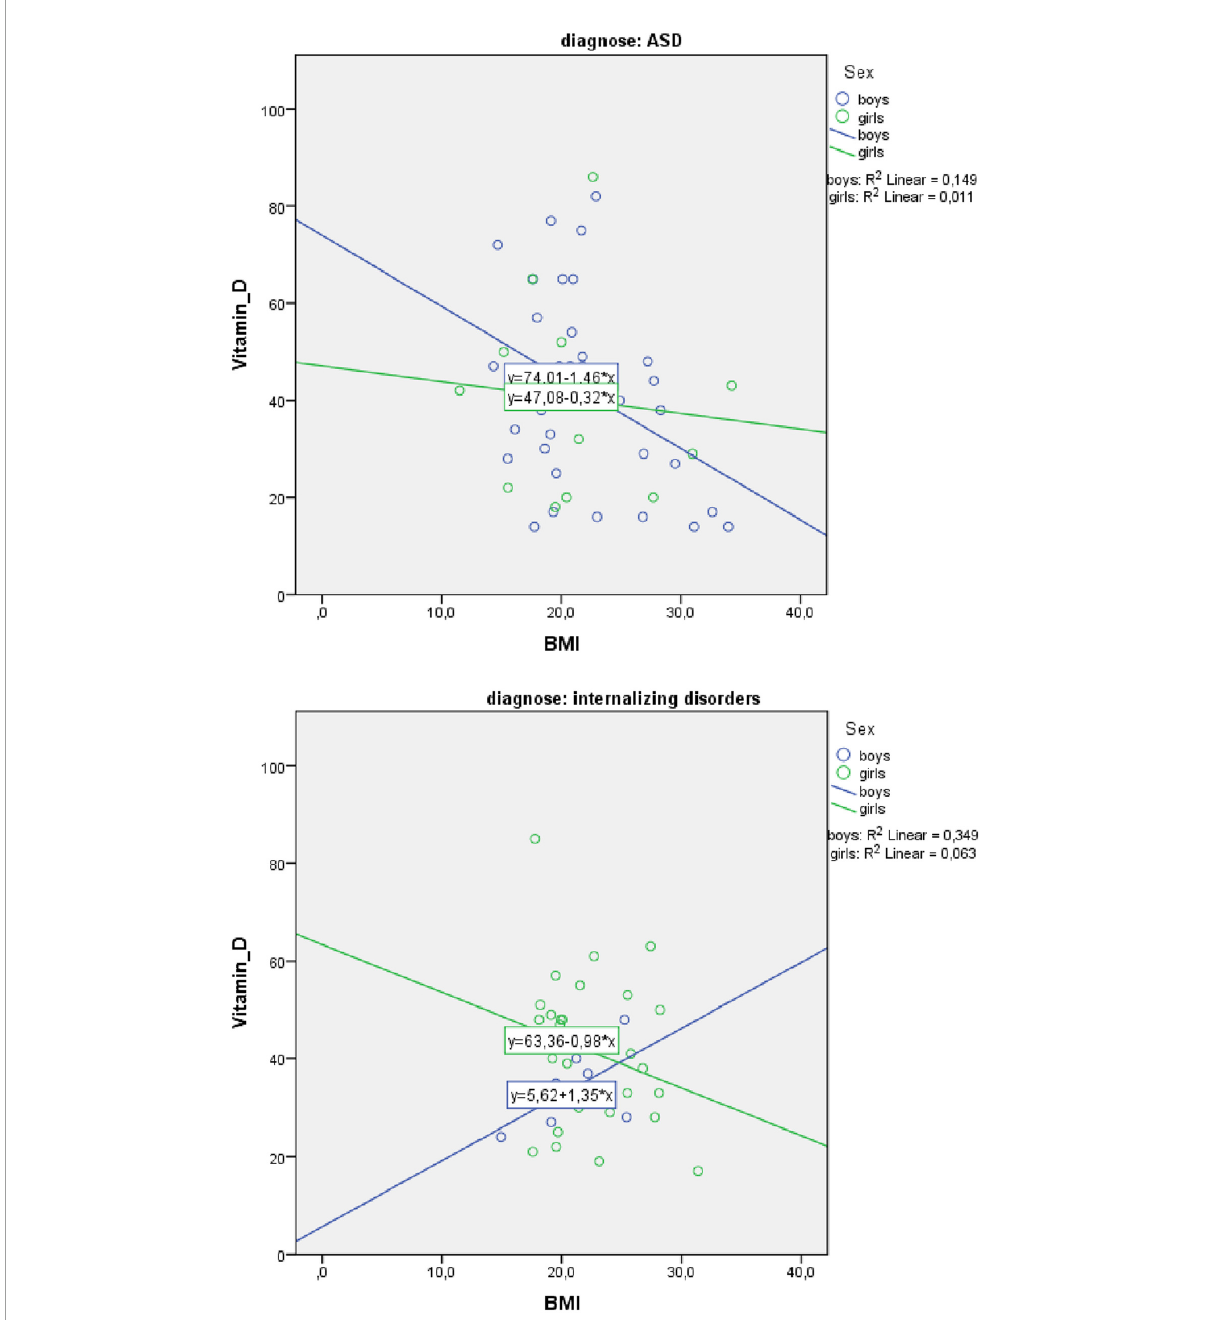
FIGURE3 Scatterplot of body mass index (BMI) and Vitamin D3 level for boys and girls separately for autism spectrum disorder (ASD) and internalizing